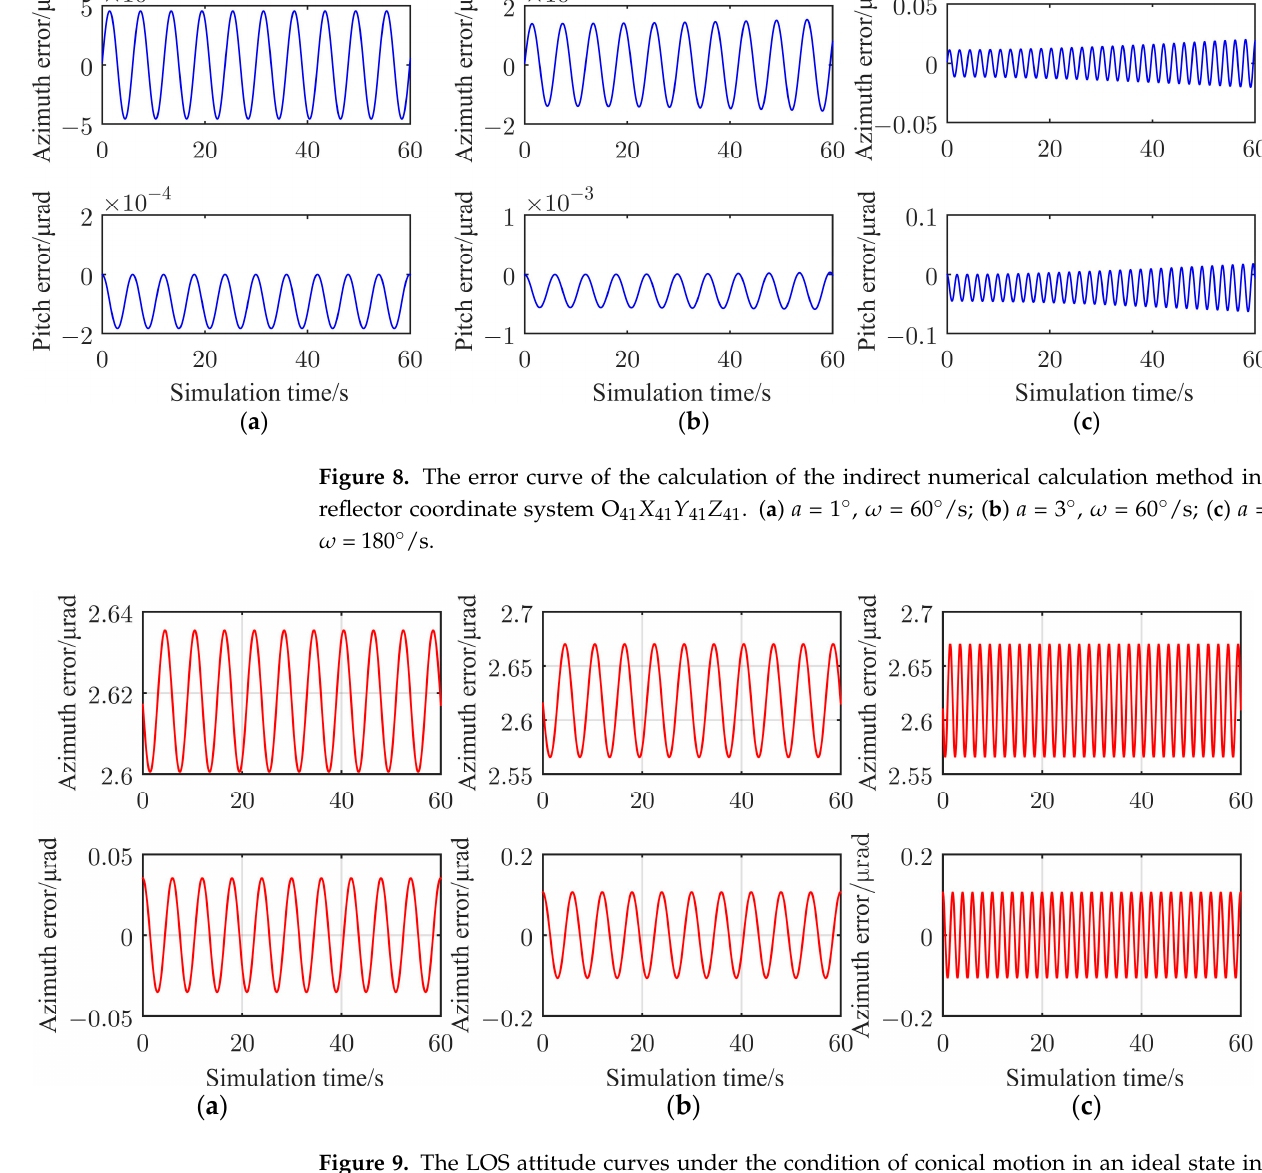
Figure 9. The LOS a tt itude curves under the condition of conical motion in an ideal state in the Figure 9. The LOS attitude curves under the condition of conical motion in an ideal state in the reflector coordinate system O 42 X 42 Y 42 Z 42 . ( a ) a = 1 ◦ , ω = 60 ◦ /s; ( b ) a = 3 ◦ , ω = 60 ◦ /s; ( c ) a = 1 ◦ , ω = 180 ◦